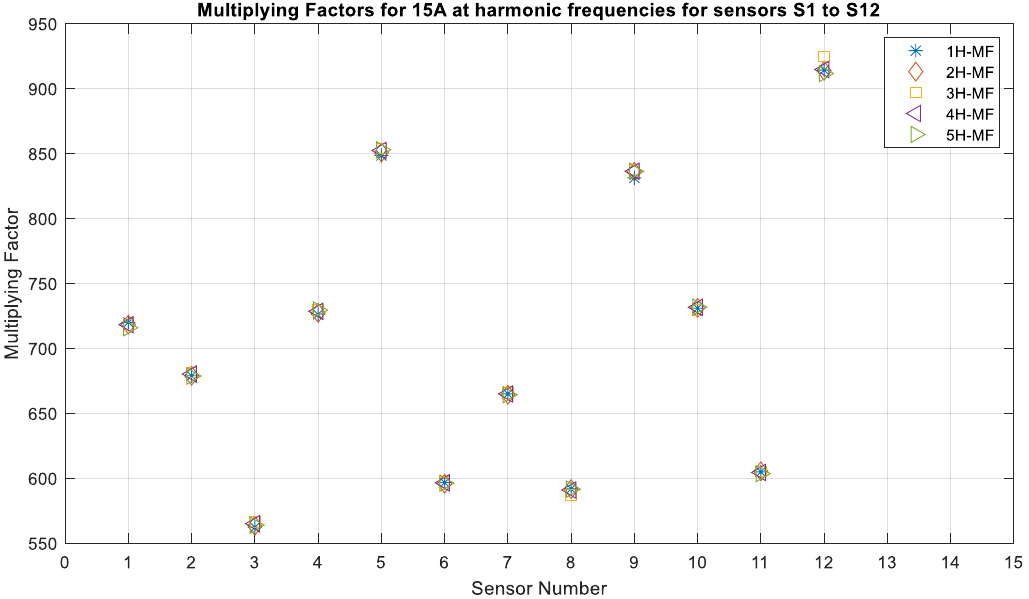
Figure 19. Multiplying factors of all sensors for 15 A, 7 mm, 60 Hz and its harmonics: WI and NI